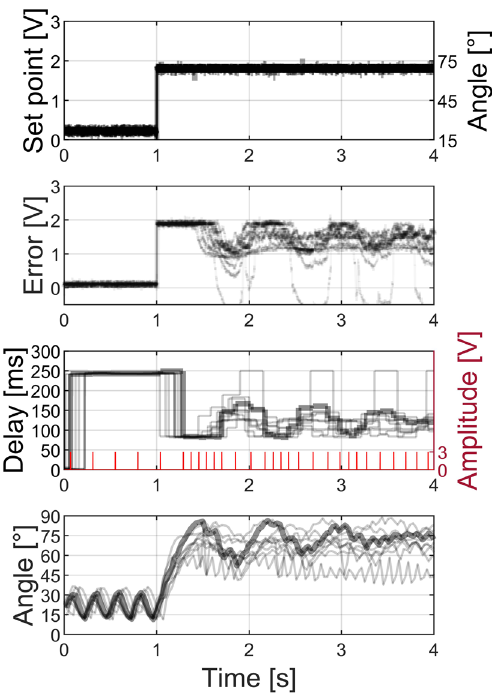
Figure 5. A set point voltage is applied to determine the desired angle of the leg. The error between set point and feedback signals is converted into a stimulation pulse pattern (red), and a corresponding inter-pulse delay. The stimulation pattern triggers a response in the leg angle, which is extracted from video recordings. The black traces show 10 repetitions of the same experiment with the thicker black traces corresponding to the indicated pulse